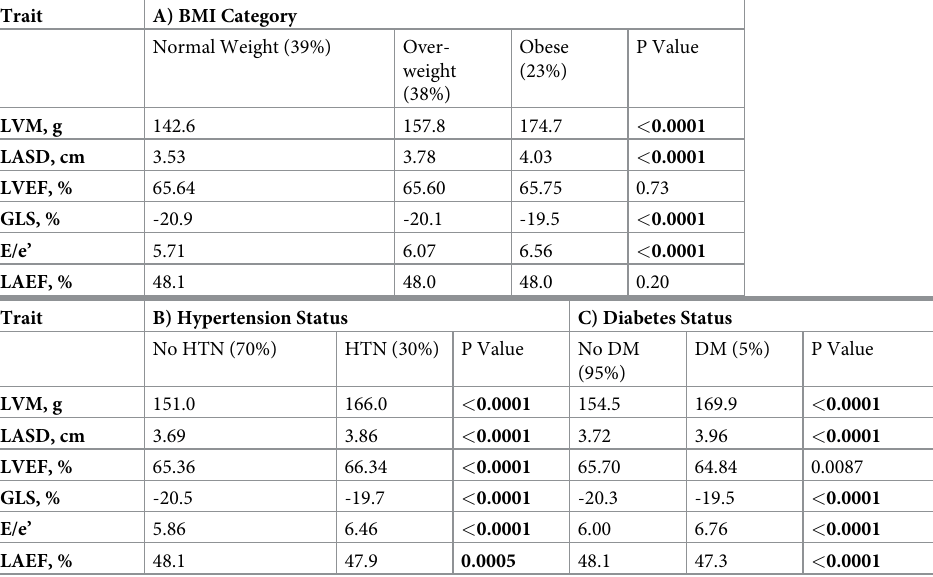
Least squares means of left ventricular mass (LVM), left atrial systolic dimension (LASD), left ventricular ejection fraction (LVEF), global longitudinal strain (GLS), E/e’, and left atrial emptying fraction (LAEF) according to A) body mass index (BMI) category (normal weight: BMI < 25kg/m 2 , overweight: 25kg/m 2 � BMI < 30kg/m 2 , obese: BMI � 30kg/m 2 ), B) hypertension status (HTN), C) and diabetes status (DM). All models are adjusted for